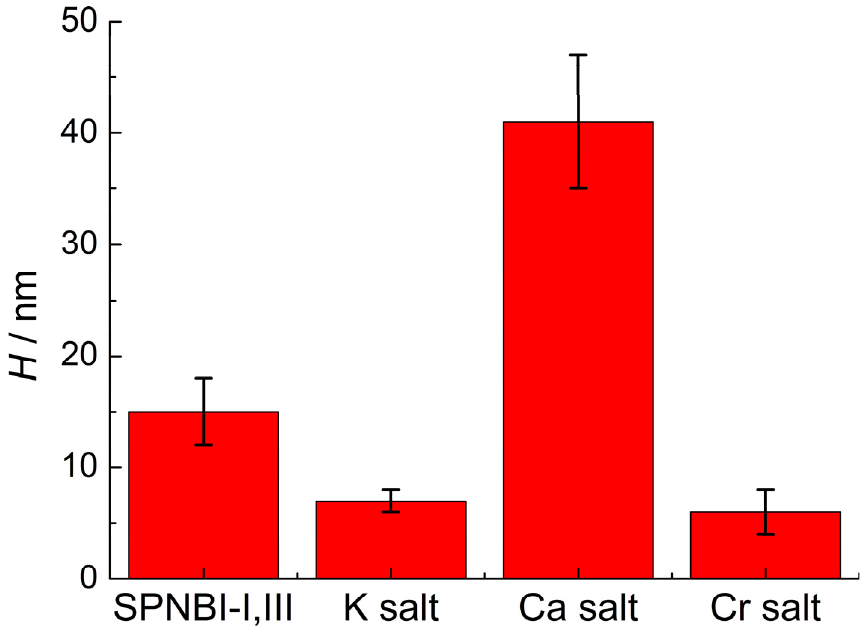
Figure 6. The thickness of the coatings ( H ) prepared from SPNBI-I,III and its K, Ca, and Cr salts by the EBD method and measured using AFM.